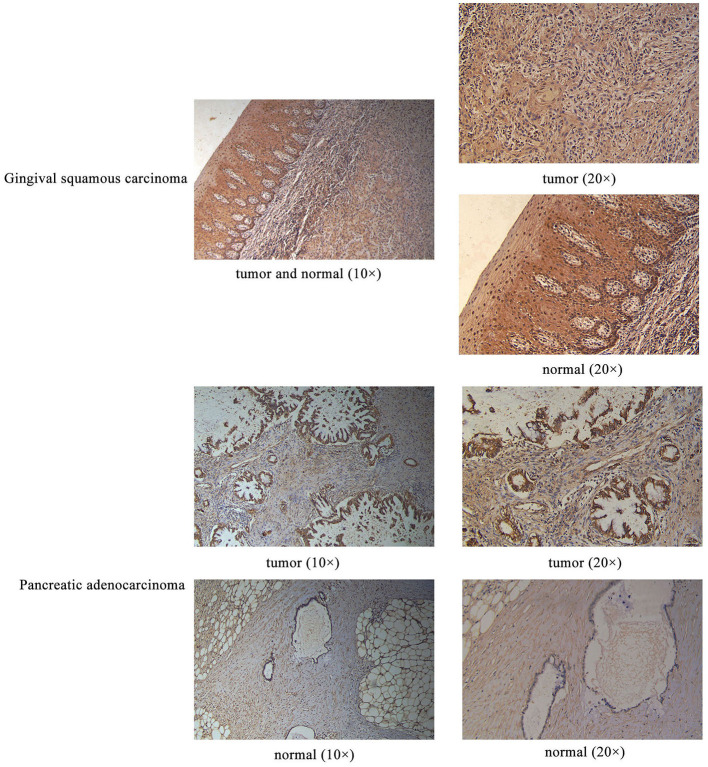
IHC results of RPGRIP1L protein expression in the patient's gingival squamous carcinoma and pancreatic adenocarcinoma. Magnification for all images: 20×.